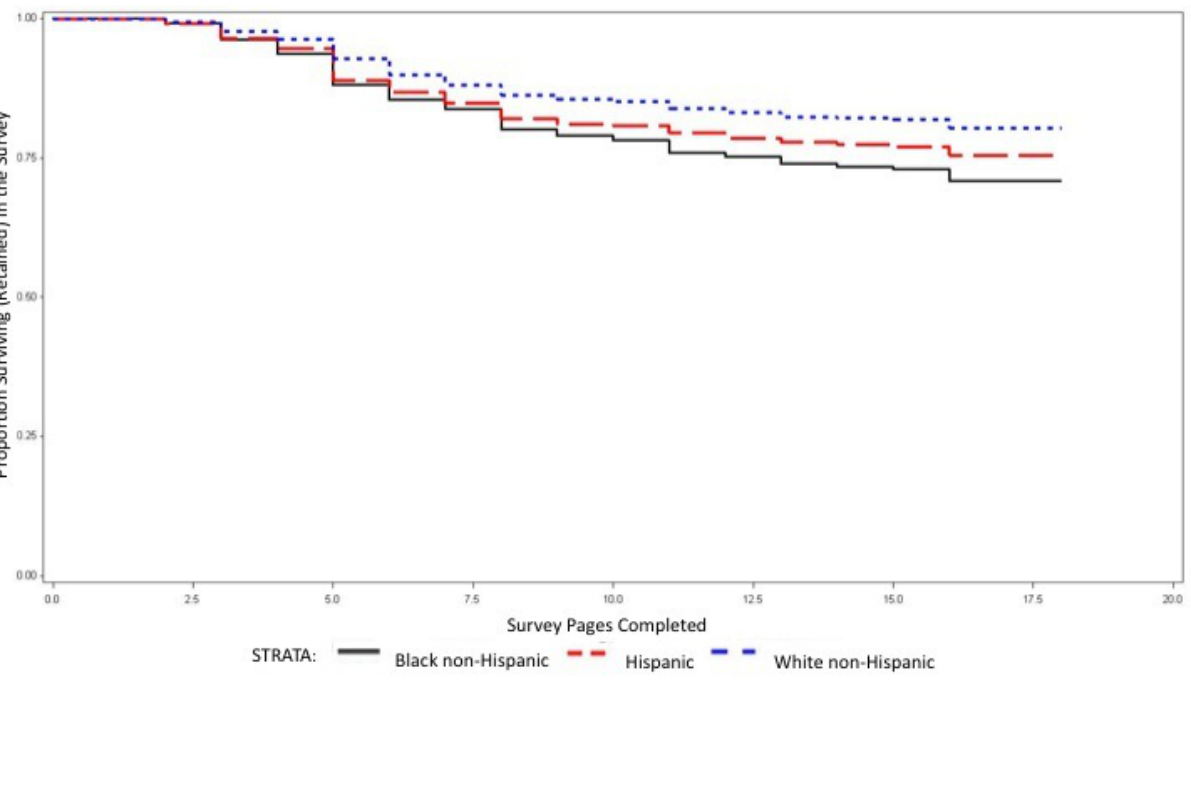
Figure 3. Retention in an online behavioral risk survey among participants reporting only male partners in the past 12 months, by race/ethnicity of the participants in the United States in